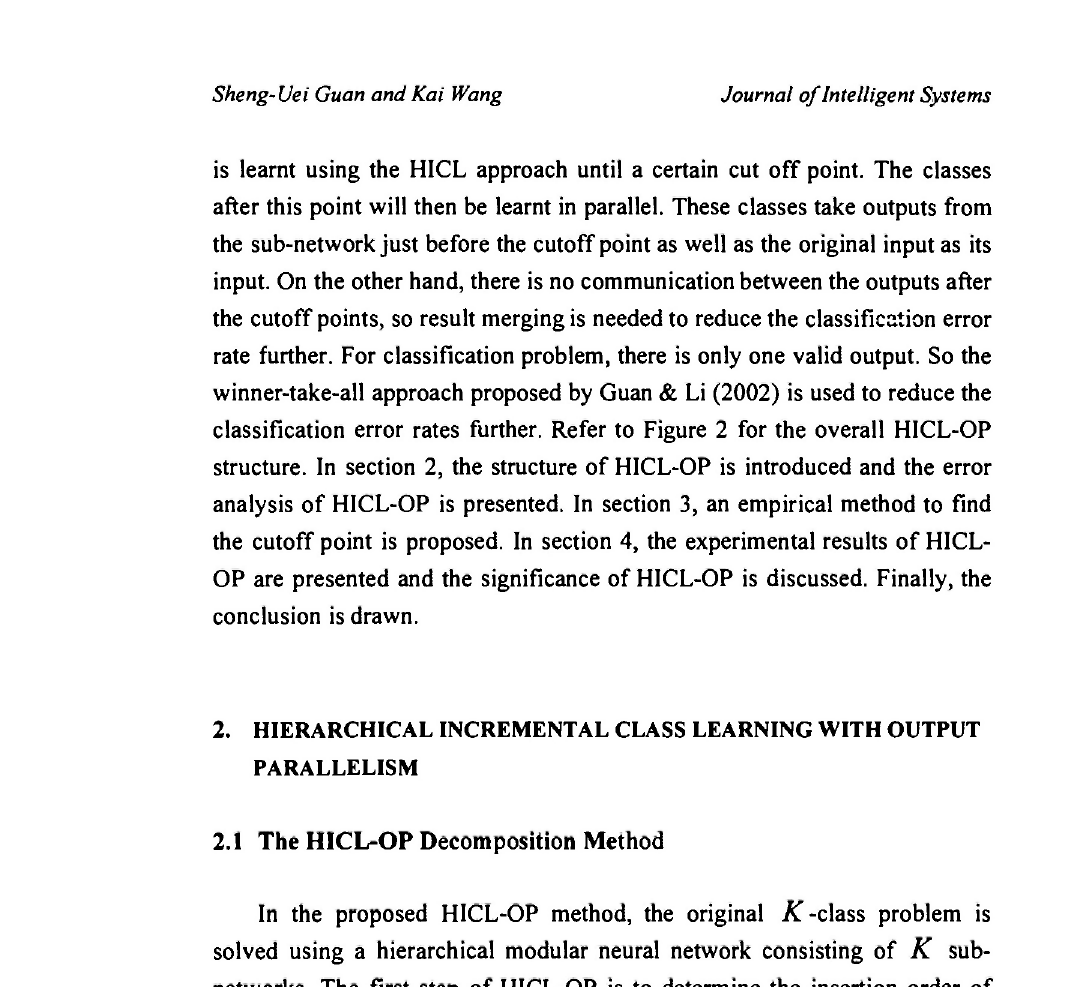
Refer to Figure 3 for a simplified flow